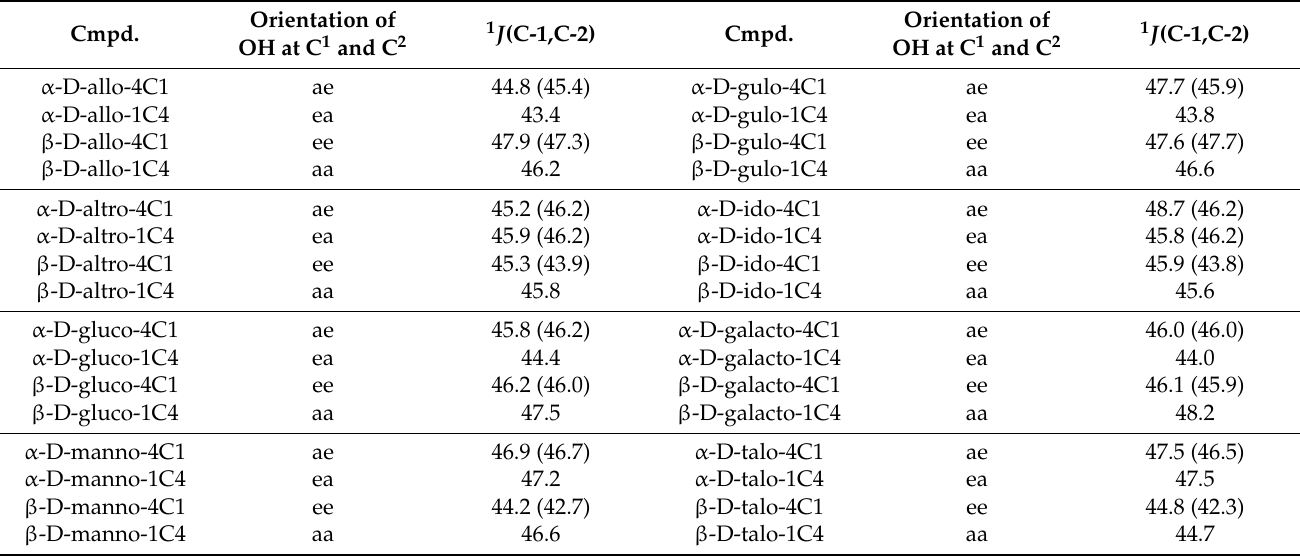
Figure 31. Rotational surface of 1 J (C-1,C-2) of ( a )— α -D-mannoseptanose and ( b )— β -D-mannoseptanose. Reproduced from the PhD Thesis by Danilova [136]. Table 3. One-bond spin-spin coupling constants 13 C- 13 C (Hz) of the α and β forms of D-hexopyranoses calculated at the SCPT INDO level as compared to experiment (given in parenthesis). For structures, see Scheme 4. Compiled from the PhD Thesis by Danilova